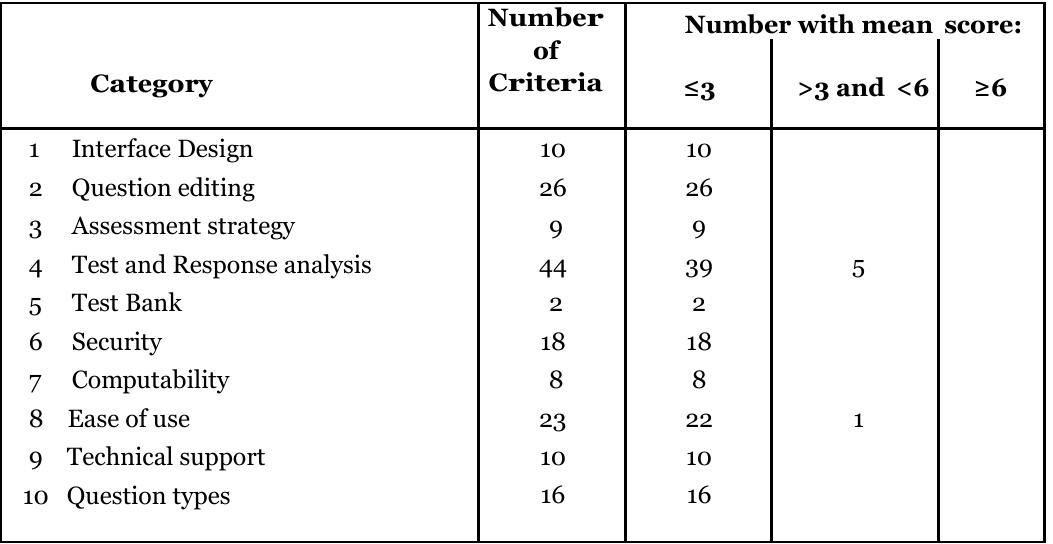
Identification of Criteria for